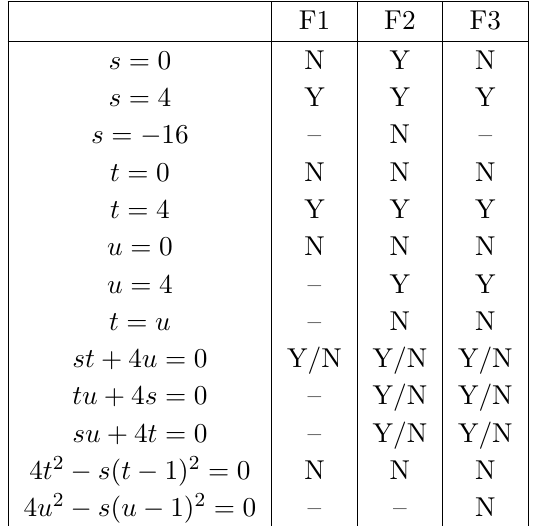
Table 1. The full list of singularities other than in(cid:12)nity is shown, as well as whether it is a branching point (marked as \Y") or not (marked as \N"). If such point is not a singular point of corresponding family, \-" is shown. Note that we adopt u = For st + 4 u = 0 it becomes a branching point only when s > 0 ; t > 0, thus we mark it as \Y/N", similarly for the other two tu + 4 s = 0 and su + 4 t = 0.